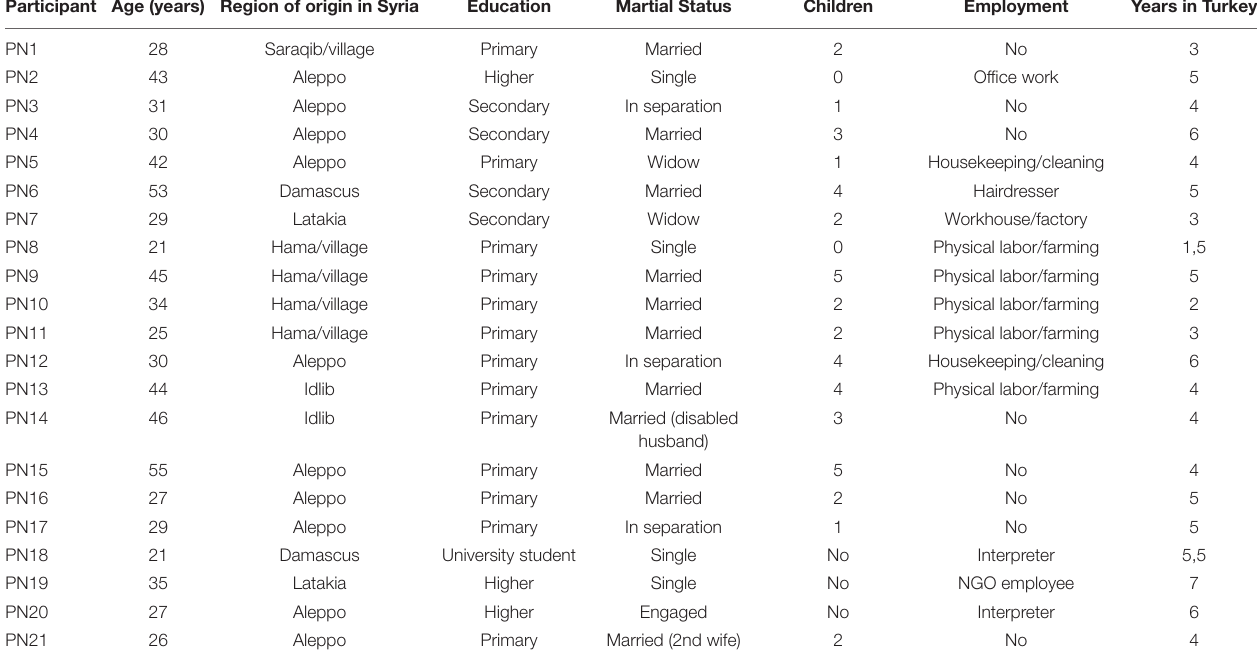
TABLE 1 | Demographic characteristics of participants (Study 1).